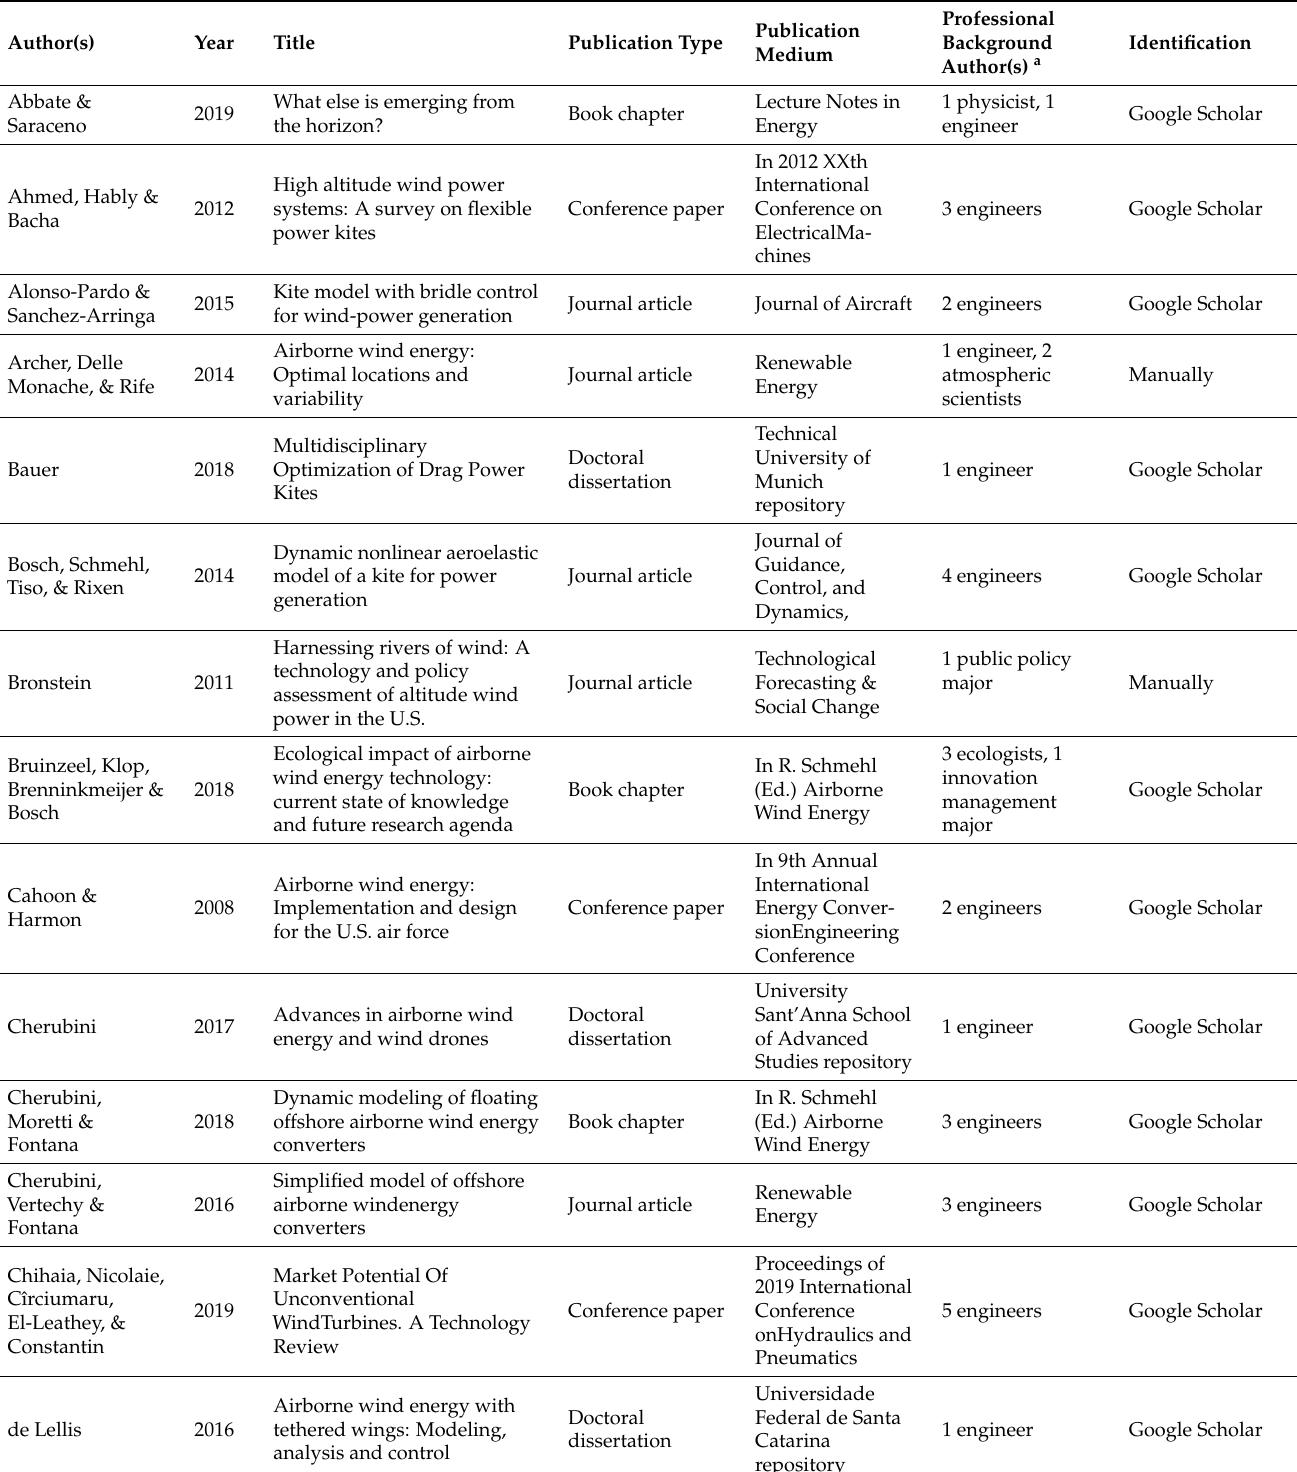
Table A2. Publication details of the papers selected for the review on the social acceptance of